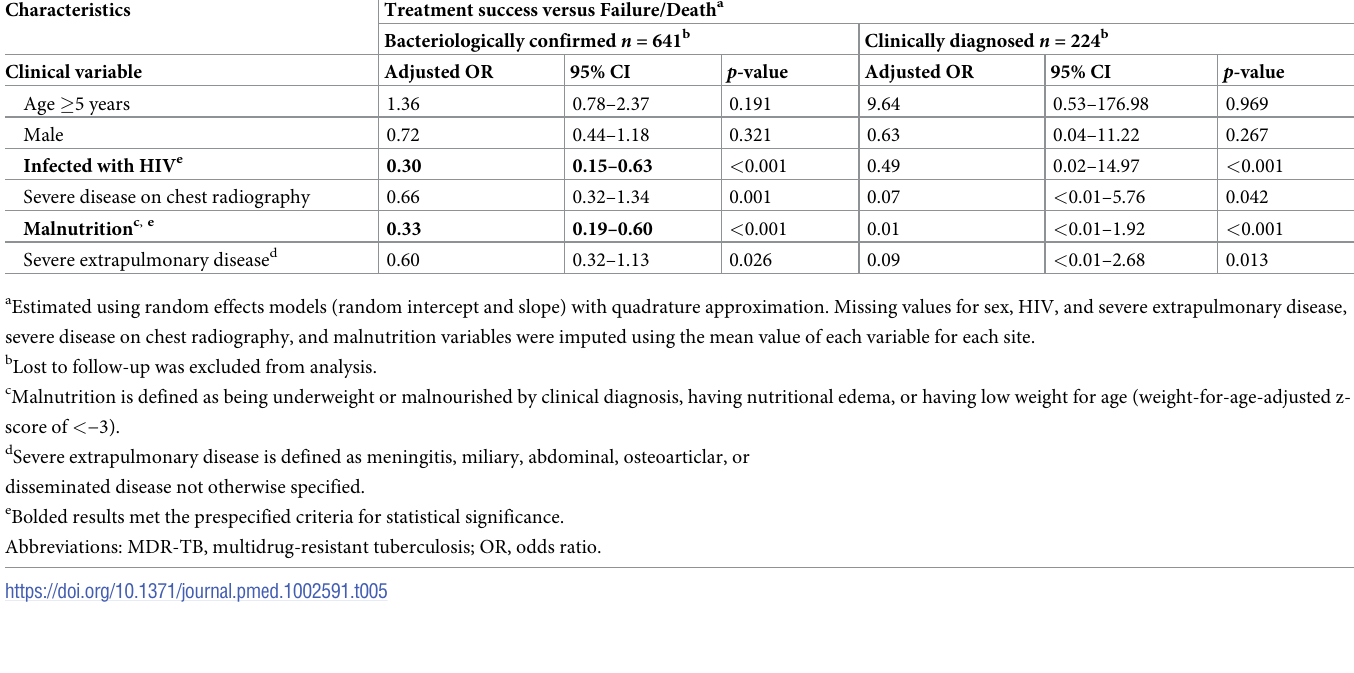
Table 5. Clinical variables associated with treatment outcome in children with MDR-TB: N = 975. Characteristics